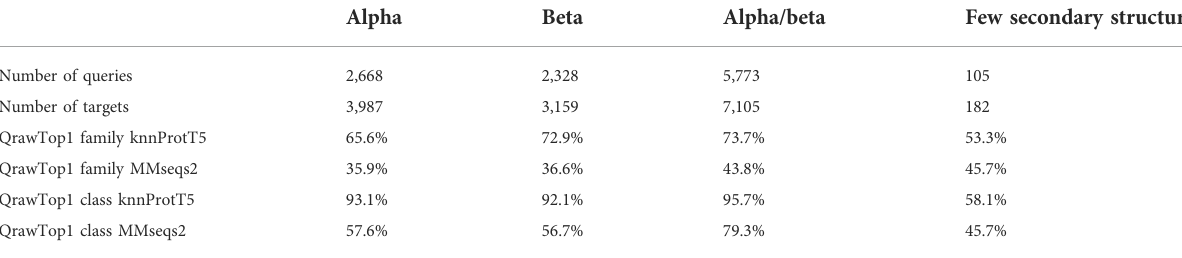
TABLE 2 Class imbalance for CATH hierarchy a